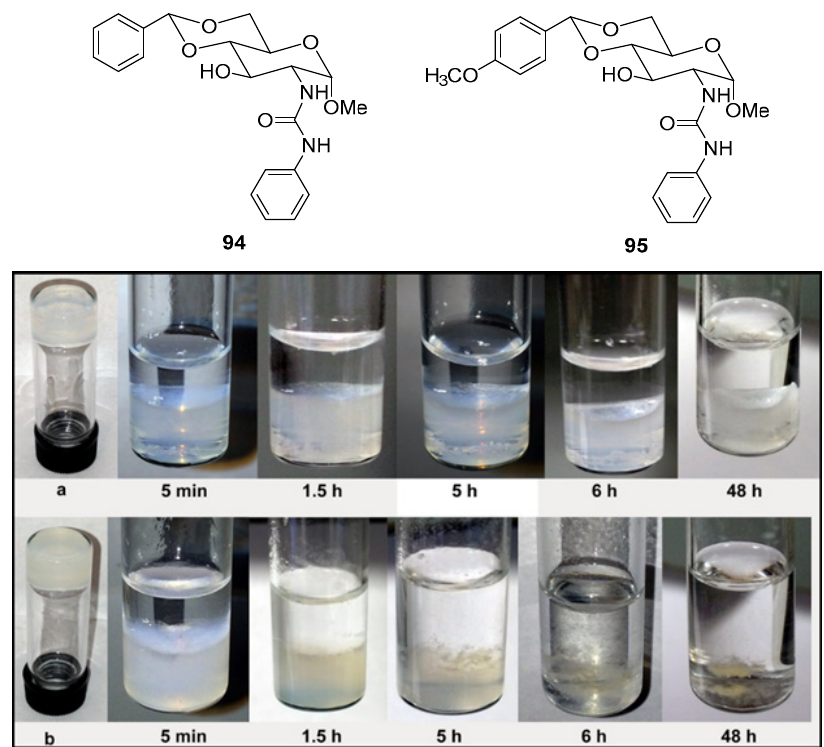
Figure 55. Photographs of respective gels in acidic conditions. ( a ) A gel formed by compound 94 in DMSO/H 2 O (1:2) at 5 mg/mL. ( b ) A gel formed by compound 95 in DMSO/H 2 O (1:2) at 5 mg/mL. Reprinted with permission from [35]. Copyright 2014 Beilstein-Institute.